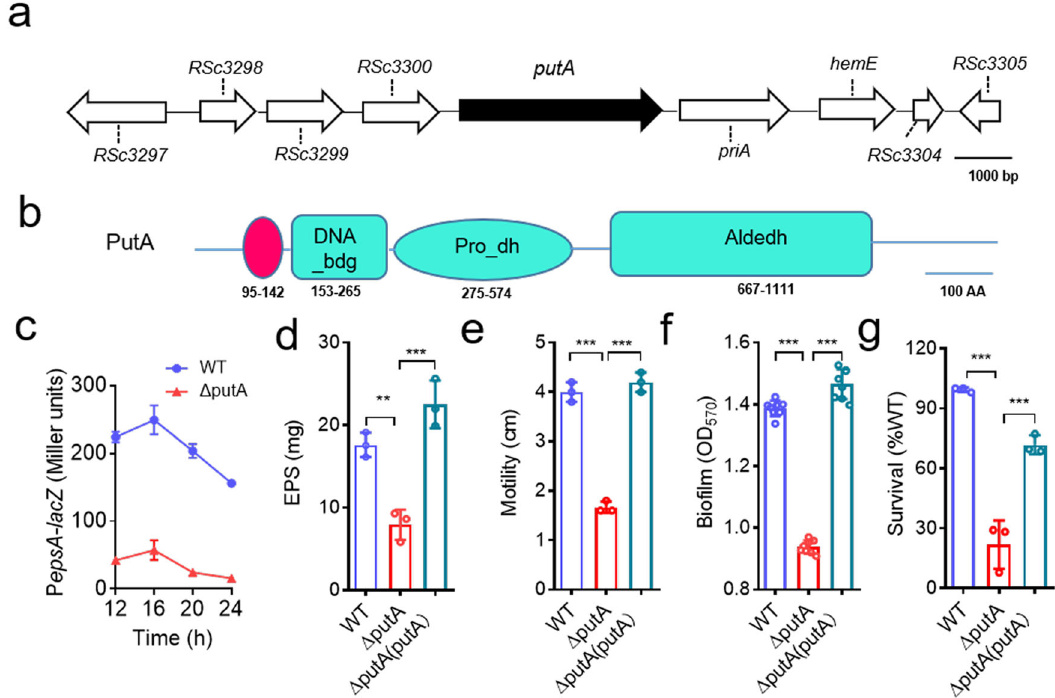
Fig. 1 Effects of PutA on virulence-related phenotypes. a Genomic organization of the putA region in R. solanacearum GMI1000. b Domain structure analysis of PutA in R. solanacearum GMI1000 (HMMER, https://www.ebi.ac.uk/Tools/hmmer/), the fi rst box represents the proline utilization A proline dehydrogenase N-terminal domain (95-142). c Time course analysis of the effect of PutA on epsA gene expression, which was measured by assessing the β -galactosidase activity of the epsA - lacZ transcriptional fusions in the GMI1000 wild-type and putA mutant strains. The wild-type strain, the putA mutant strain, and the putA complemented strain were evaluated for the following virulence-related phenotypes: EPS production ( d ), motility activity ( e ), bio fi lm formation ( f ), and antioxidant activity ( g ). The survival rate of the R. solanacearum wild-type strain was arbitrarily de fi ned as 100% and used to normalize the survival rates of the putA mutant and the complementation strains. Results in c , d , e , f and g are mean ± standard deviations of three or six independent experiments. * p < 0.05; ** p < 0.01; *** p < 0.001 (unpaired t -test).